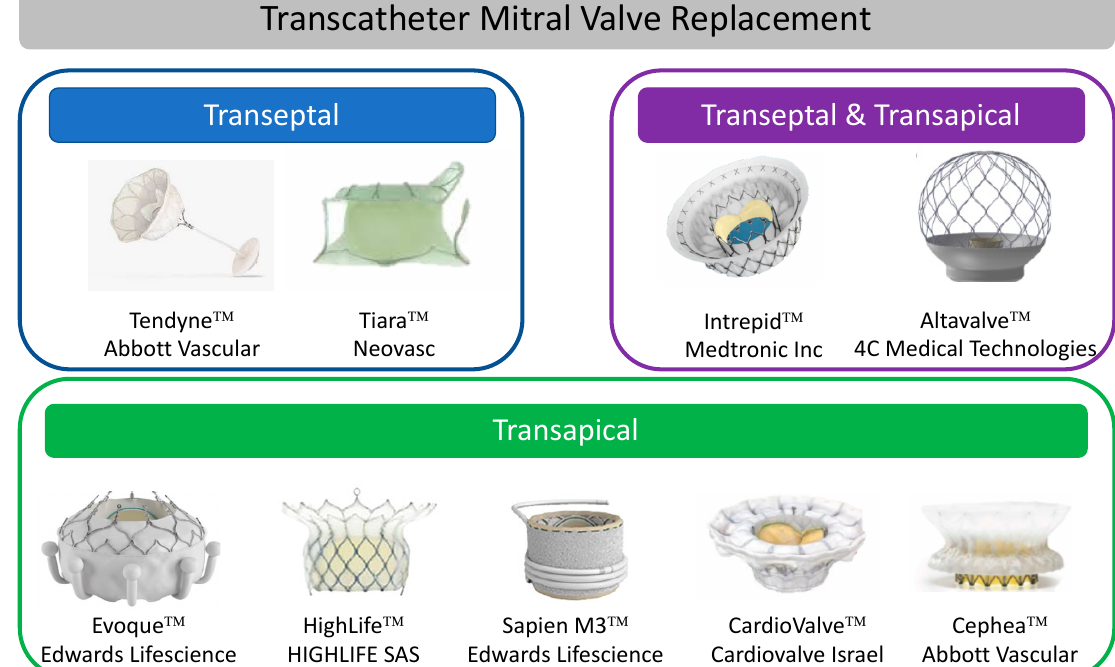
Figure 4. Transcatheter Mitral Valve Replacement.